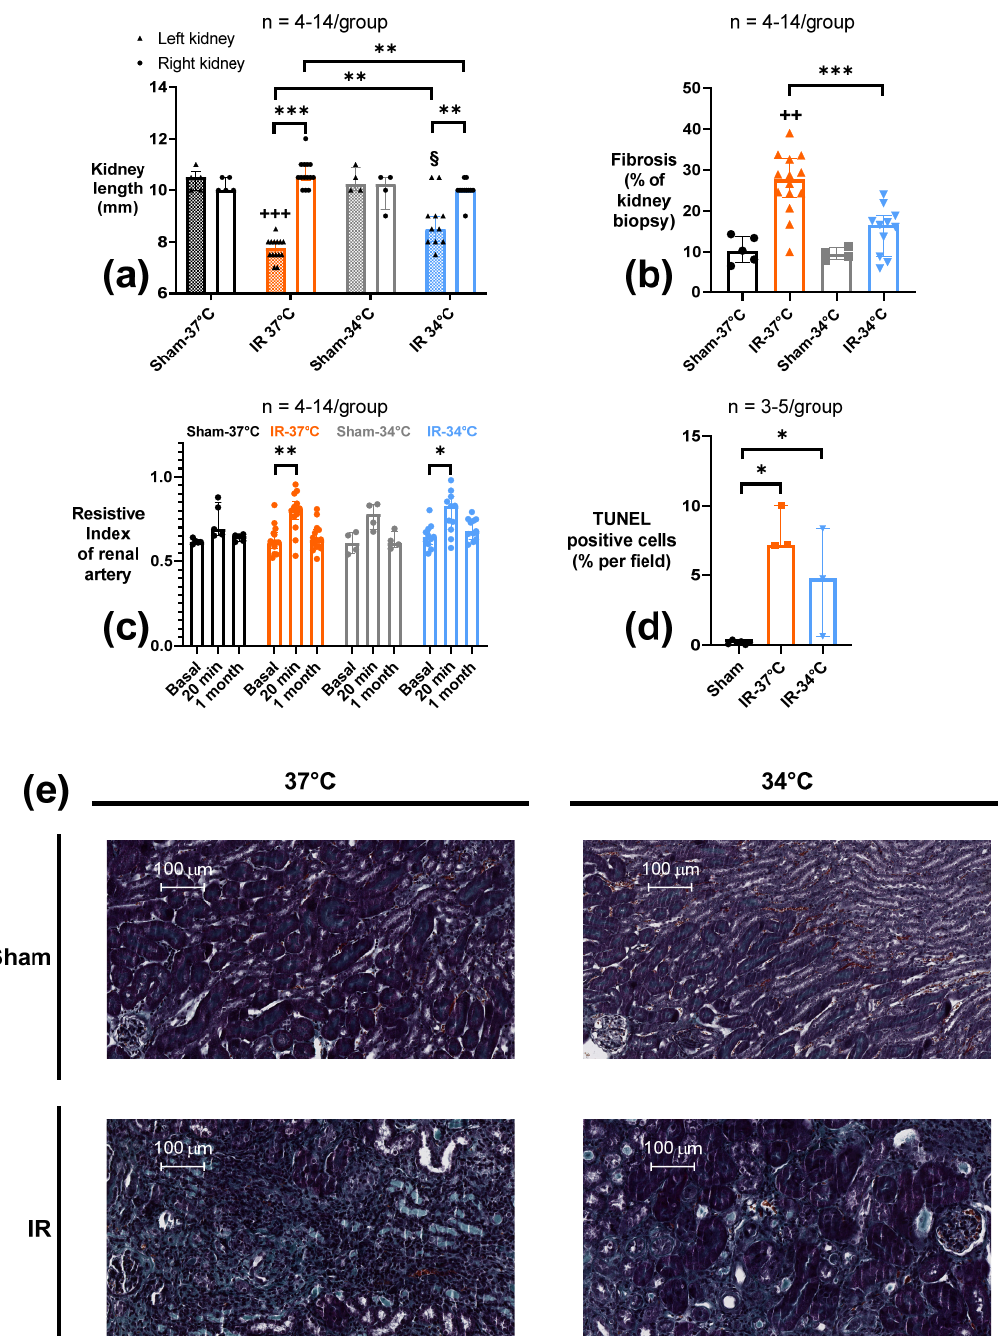
Figure 2. Renal functional parameters measured after 15 min of unilateral renal ischemia where the mice body temperature was maintained at normothermia (IR-37 ◦ C) or at mild therapeutic hypothermia (mTH) (IR-34 ◦ C) followed by 1 month of reperfusion, or after a Sham procedure with the same body temperature (Sham-37 ◦ C and Sham-34 ◦ C). ( a ) Kidney length (long axis) was measured ex vivo to assess renal size modification in the ischemic kidney and the contralateral one. Ischemia-reperfusion induced renal atrophy of the ischemic kidney in both IR-groups, but ischemic kidneys remained bigger. ( b ) Histology with Masson’s trichrome staining was used to quantify chronic renal fibrosis, through a computerized automatic quantification of fibrosis based on the ratio between green pixels (representing fibrosis) and all the pixels representing the kidney biopsy, and expressed as a percentage. Ischemia-reperfusion led to the development or extensive renal